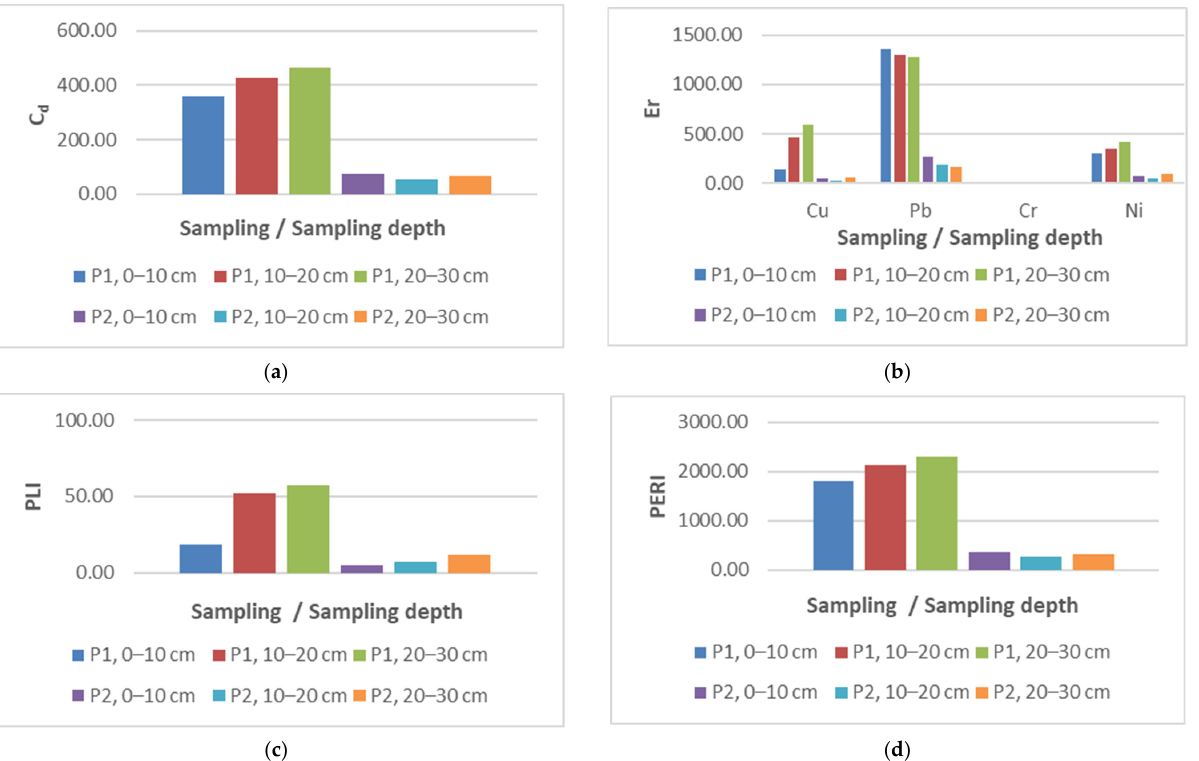
Figure 2. Initial metal concentration and pH of soil samples as a function of sampling location and depth.